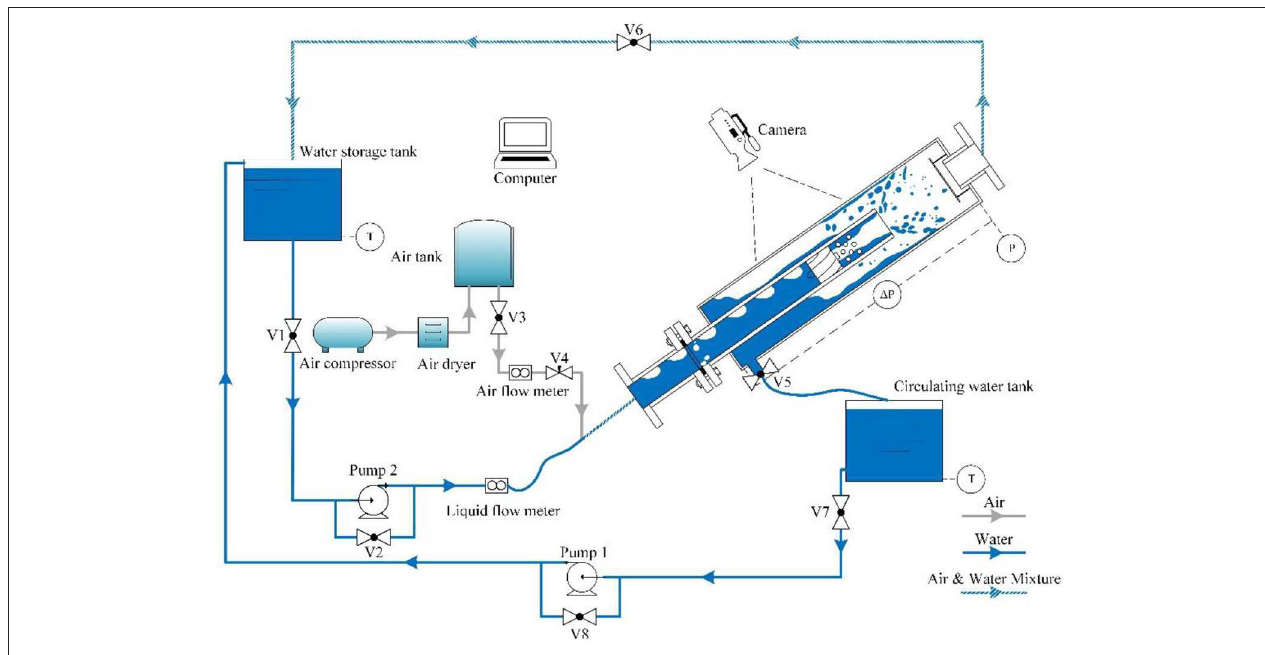
FIGURE 3 | Experimental system.